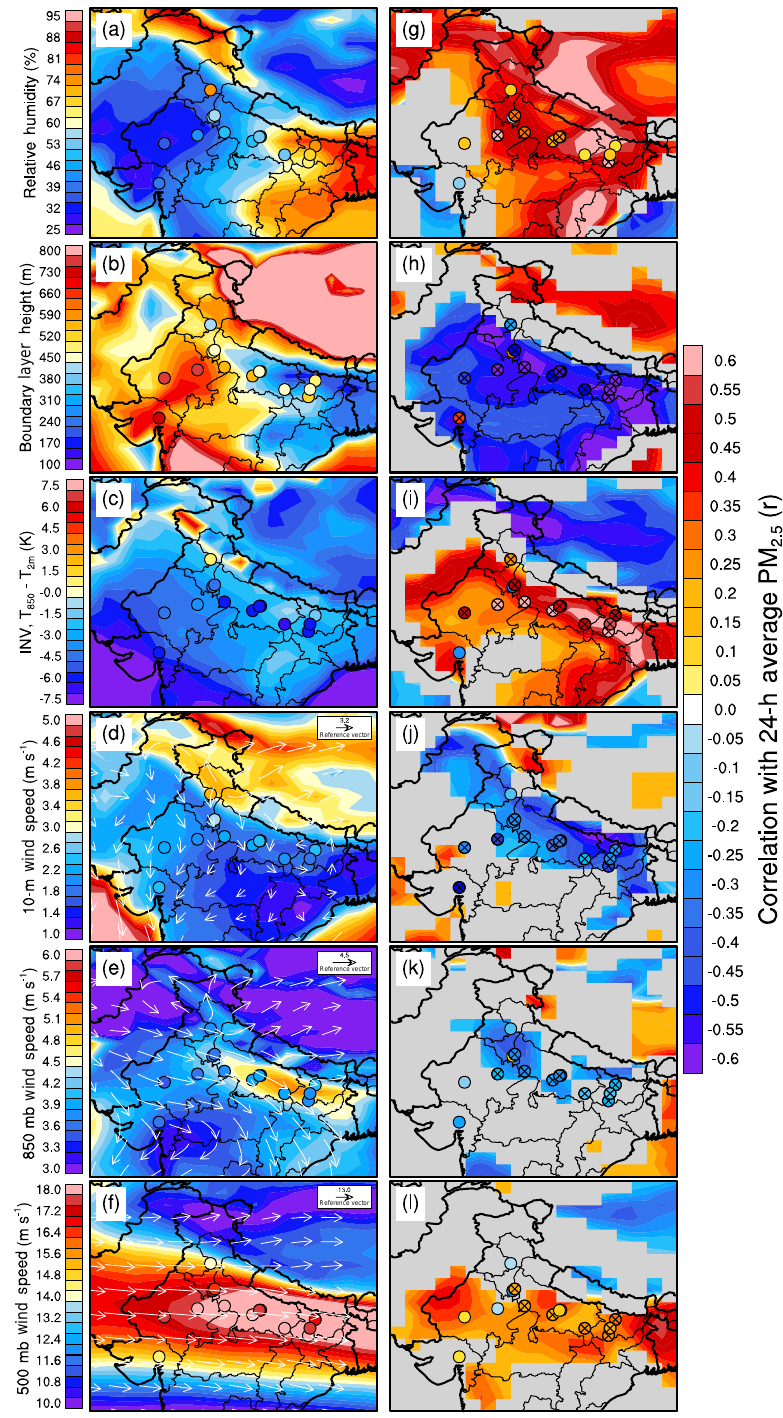
Figure 5. (a–f) Average meteorological conditions and (g–l) their correlations with daily average PM 2 . 5 for the observations (filled circles) and the AM4-CMIP6-wet (background) over 1 October 2015–31 March 2016. (a, g) Relative humidity (RH, %), (b, h) boundary layer height (BLH, m), (c, i) temperature difference between 850mb and 2m (INV, K), (d, j) 10m wind flow and speed (ms − 1 ), (e, k) 850mb wind flow and speed (ms − 1 ), and (f, l) 500mb wind flow and speed (ms − 1 ). For panels (g–l) , only areas with correlations significant at the 95% confidence level based on a Student’s t test are shown for the model; circles with an “x” denote the same for the